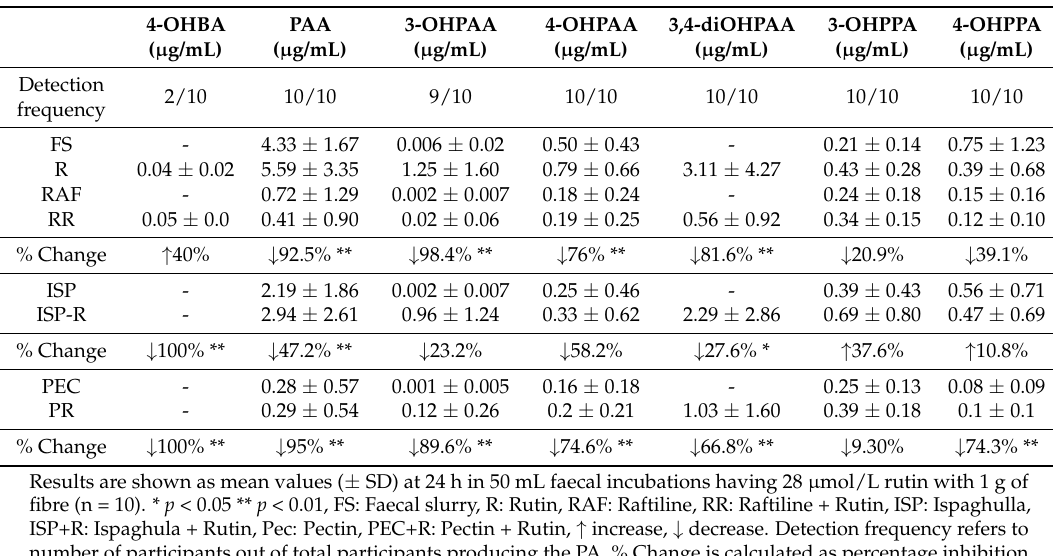
Table 2. PA (phenolic acids) concentrations in fermentations after 24